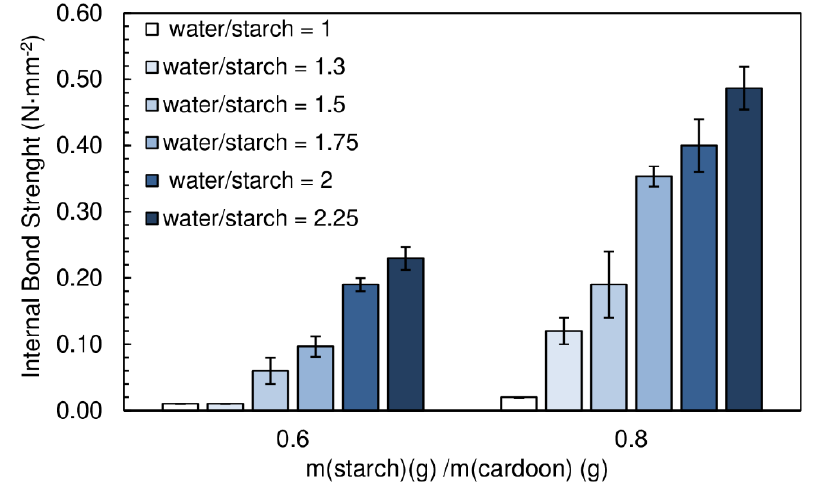
Figure 13. Effect of water content on internal bond strength of the particleboards bonded with a potato starch. All adhesive formulations had a starch/cardoon ratio of 0.6 and 0.8 and cs/starch ratio of 0.05.